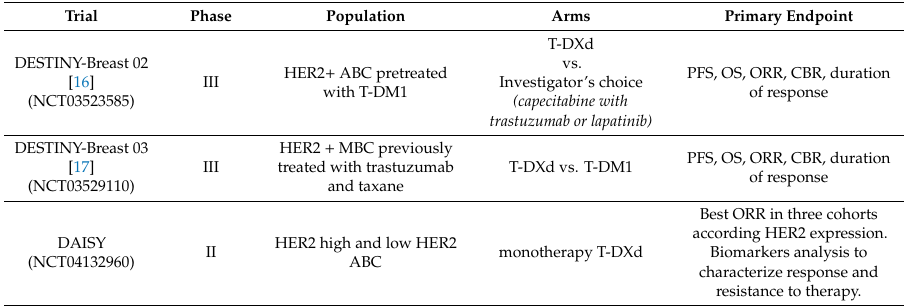
Table 1. Phase II and III trail evaluating T-DXd in HER2-positive